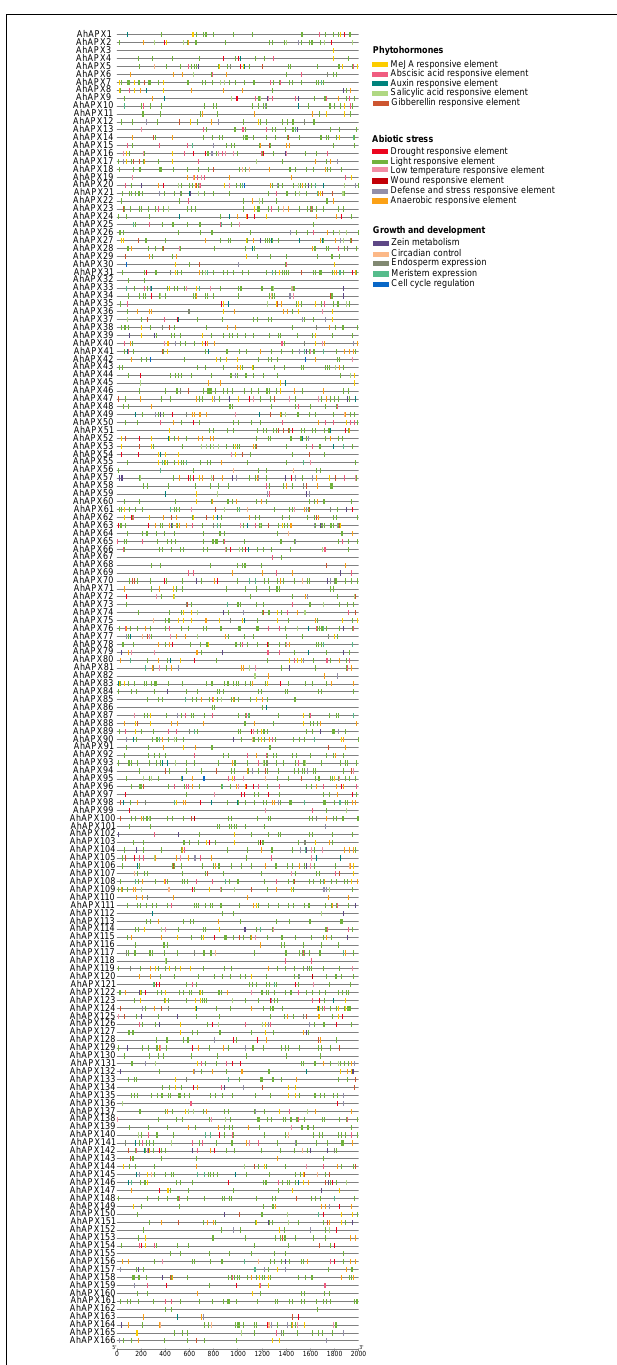
expression profiles of AhAPX genes may fluctuate under different developmental stages, phytohormone and abiotic stress